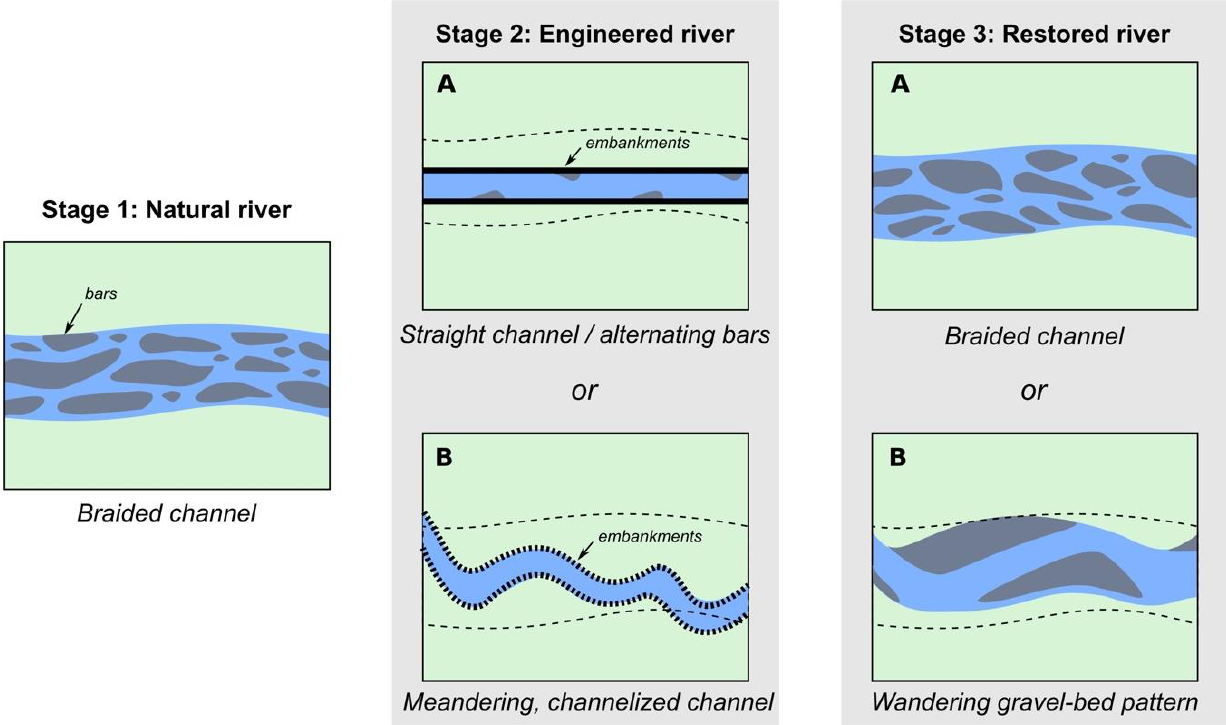
Figure 2. Some examples of modern braided-river metamorphoses, which have been expressed, after channelization works, by shortening (Stage 2A) or lengthening (Stage 2B) their watercourse. River-restoration works in Europe since the 2000s (WDF) lead to finding the initial conditions of braided rivers (Stage 3A) or to achieving an intermediate fluvial style (e.g., wandering pattern) between braided and single channel (Stage 3B). Table 1. Recent geomorphological change of rivers subdivided in three stages. (++) high; (+) moderate; ( − ) low; (o) zero. Stage 1 Before Significant Functionalization of Rivers (<18th–19th century) Channel